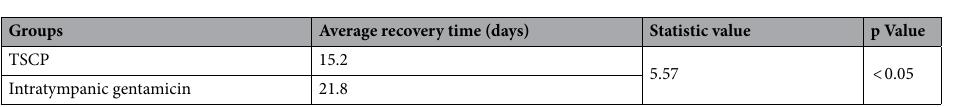
Table 6. The average recovery time of imbalance in TSCP and intratympanic gentamicin patients.